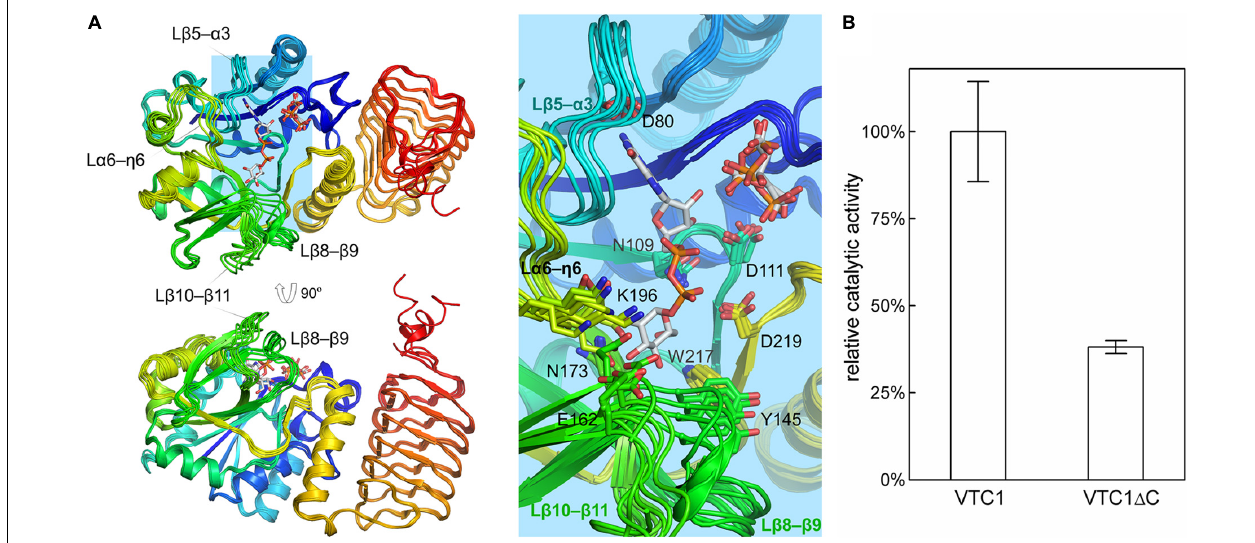
FIGURE 5 | Superimposition of VTC1 protomers and activity assay. (A) Conformational ensemble containing six conformers. GDP-Man, PPi, and citrate are in sticks. VTC1 is colored in rainbow with N-terminus in blue and C-terminus in red. Inset: details of the active site. Side chains of residues shown in Figure 4D are drawn as lines. (B) GMPase activity of VTC1 and VTC1 (cid:49) C. Bars represent standard deviation from three independent experiments.